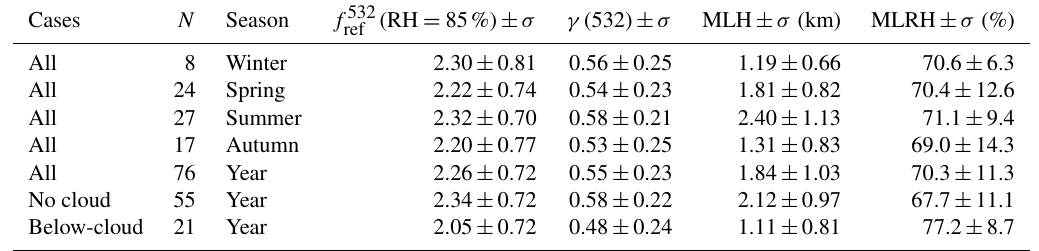
Table 4. Seasonal and yearly mean and standard deviation ( σ ) of f 532 (MLH) and the mean-layer relative humidity (MLRH). N is the number of hygroscopic cases. The yearly means are also given for the cases No cloud and Below-cloud .